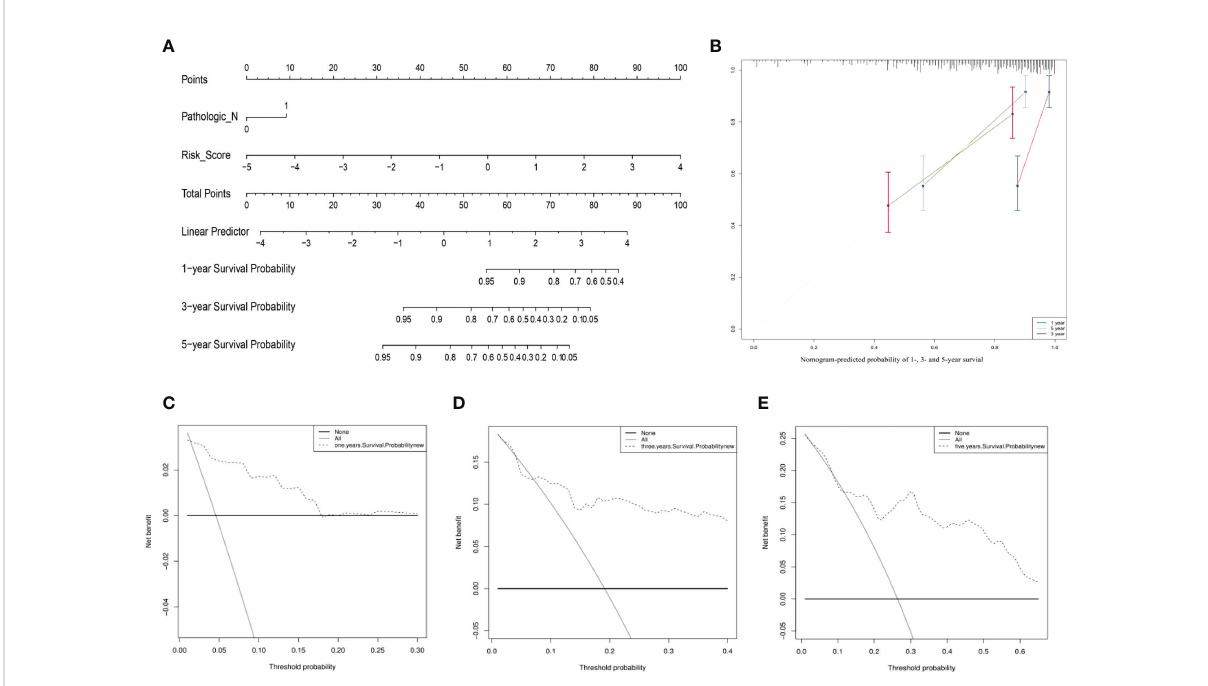
FIGURE 6 The prognostic assessment models on the basis of the three ARLs. (A) The nomogram depicting the 1-, 3-, and 5-year OS based on the Pathologic_N stage and risk score. (B) The nomogram which predicted the probability of 1-, 3-, or 5-year survival and the calibration plots which were used to estimate the consistency among the predictions of the prognostic models and the actual OS. The 45° reference line expresses ideal calibration, in which the predicted probabilities are in accordance with the realistic probabilities. The decision curve analysis